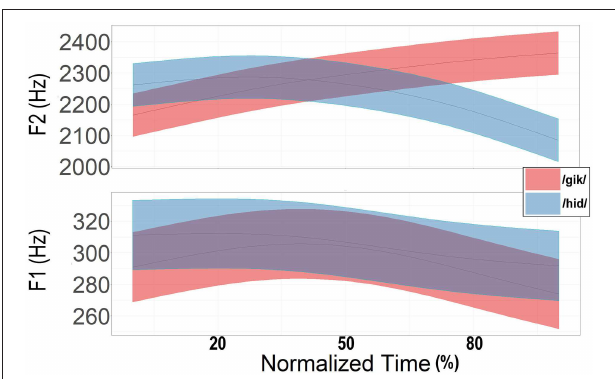
FIGURE 5 | Plots SSANOVA for /hid/ (blue) vs. /gik/ (pink).